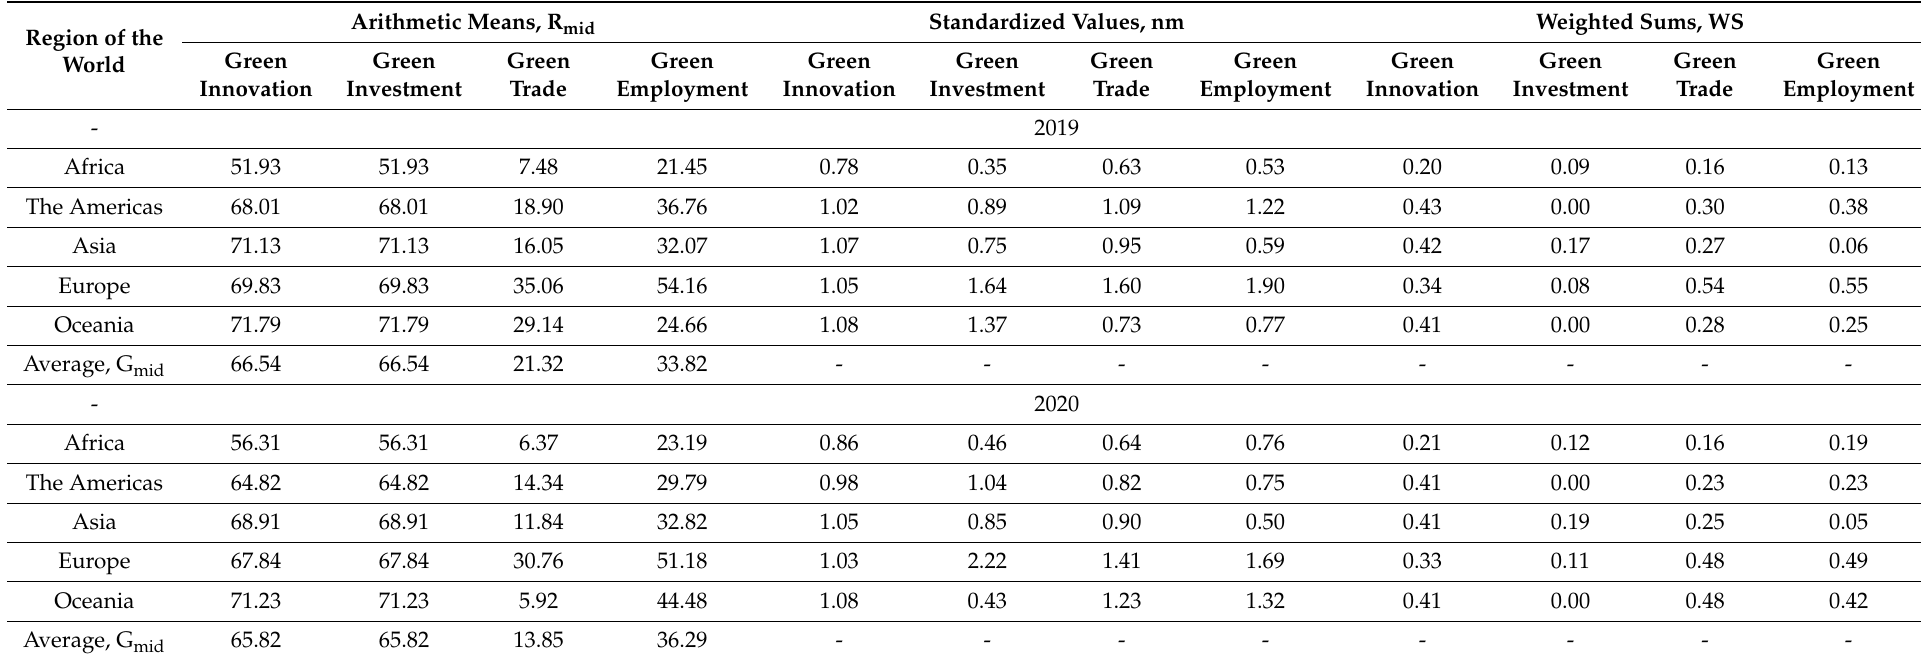
Table 3. Calculation of arithmetic means, standardized values and weighted